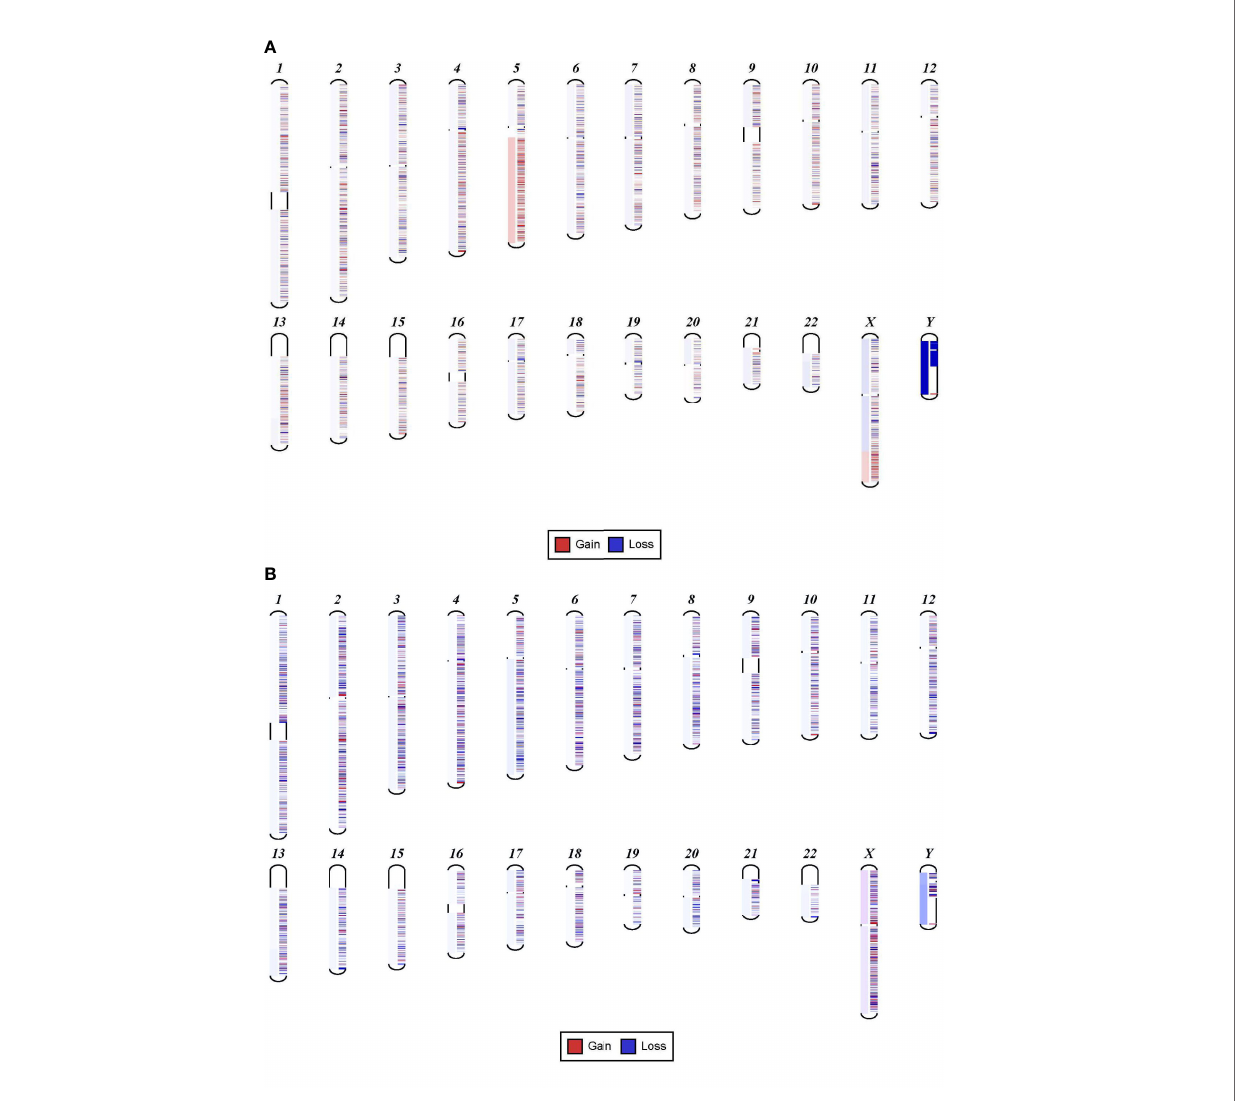
FIGURE 1 | Sensitivity of NGS in detecting chromosomal gain or loss. (A) Shows 5q gain in a sample with FLT3 mutation detected at 13%. (B) Shows 5q deletion that is very faint that can be easily missed. This sample has a mutation in TP53 at